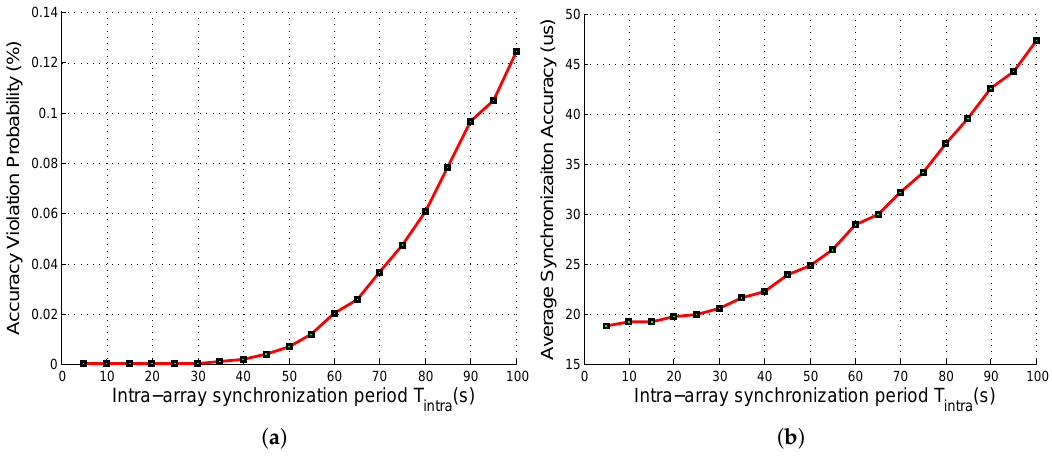
Figure 8. Intra-array synchronization metrics under different intra-array synchronization periods: ( a ) accuracy violation probability; ( b ) average synchronization accuracy.